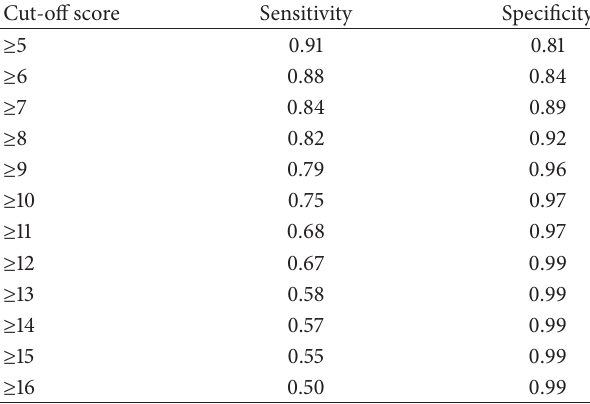
Table 2: Sensitivity and specificity of PHQ-9 at different cut-off scores.